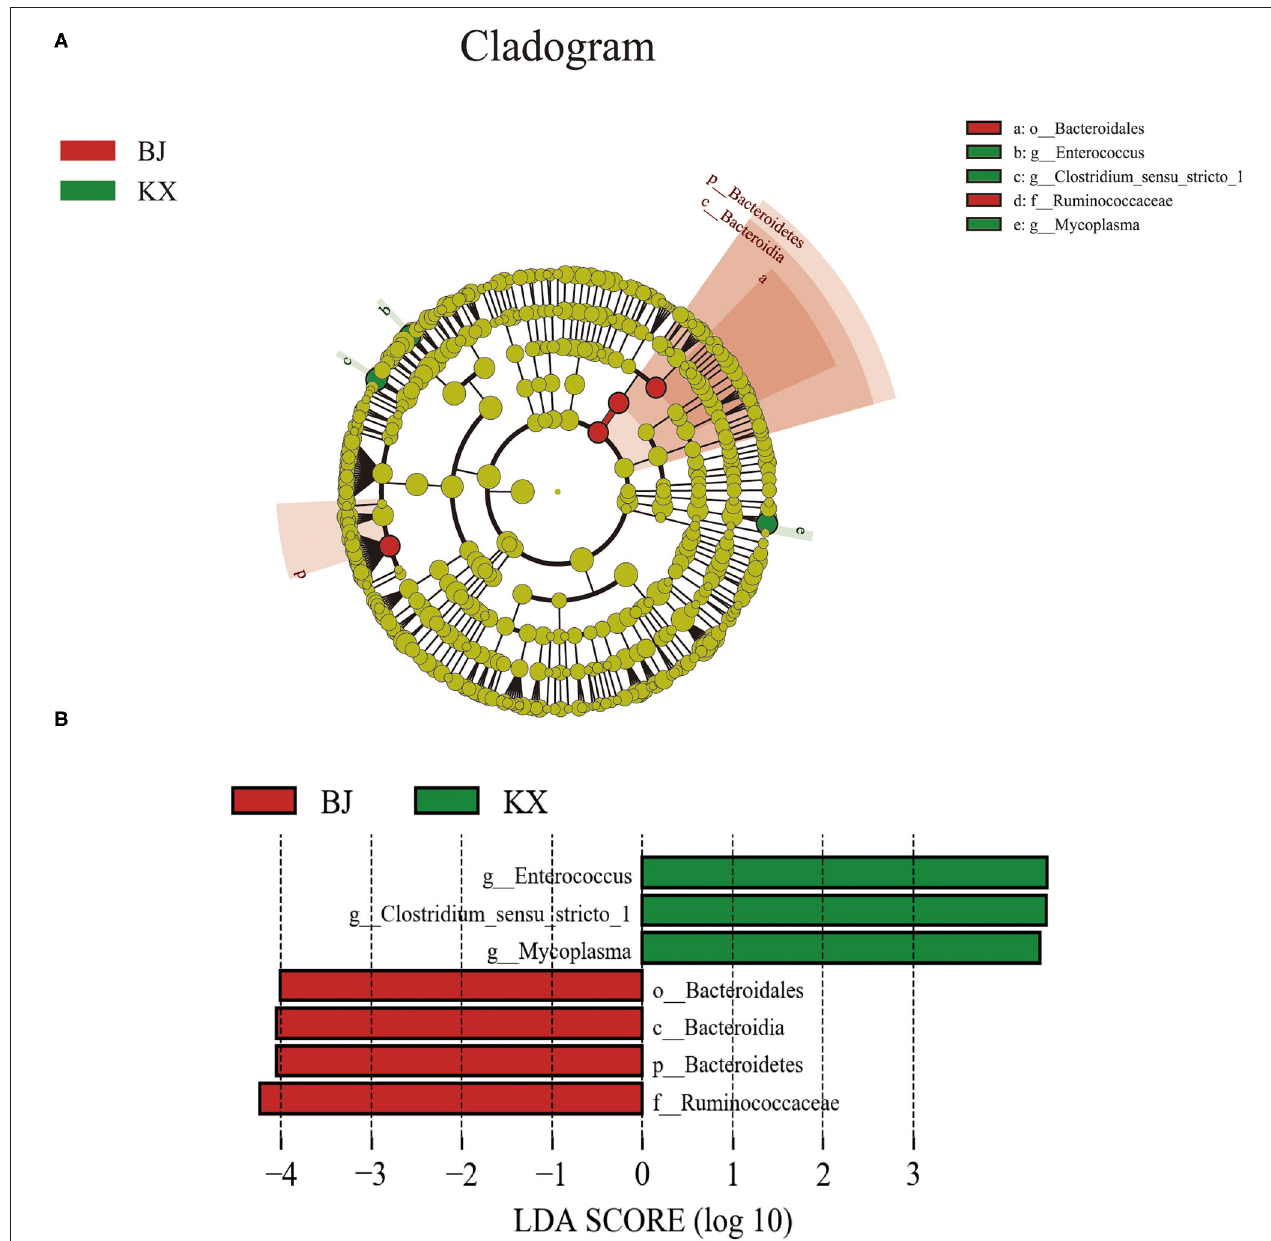
FIGURE 6 | Linear discriminant analysis (LDA) effect size (LEfSe) analysis. (A) The microbial species had significant differences in the two breeding sites. Different colors presents different groups, the species classification at the level of genus, family, order, class, and phylum were exhibited from the outside to the inside. (B) The plot from LEfSe analysis. The length of the bar column represents the LDA score. The figure exhibited the microbial with significant differences between the two breeding grounds (LDA score >